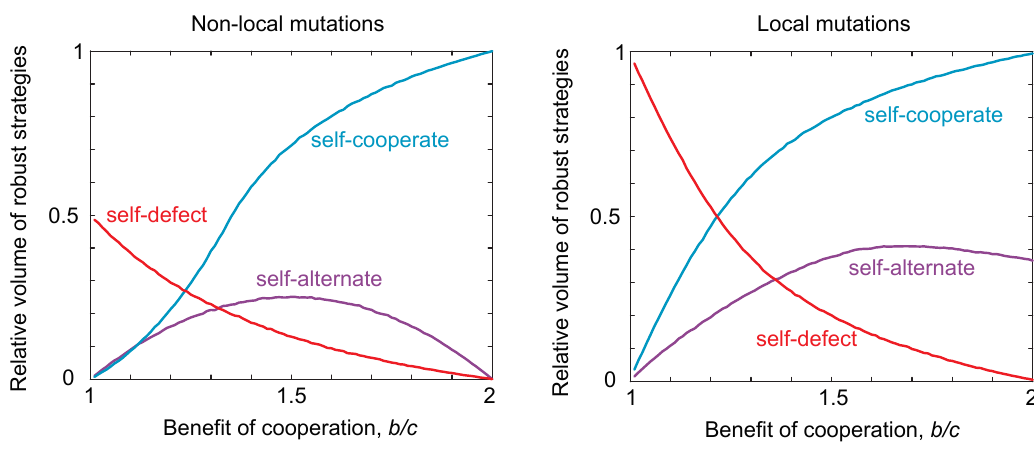
Figure 2. Robust volumes under local and non-local mutations. We considered populations playing an iterated public goods game, with payoffs R = 0 . For non-local mutations, we numerically integrated to determine the robust and R dd volumes of the different strategy classes, based on the conditions for robustness given in [16], = namely C r